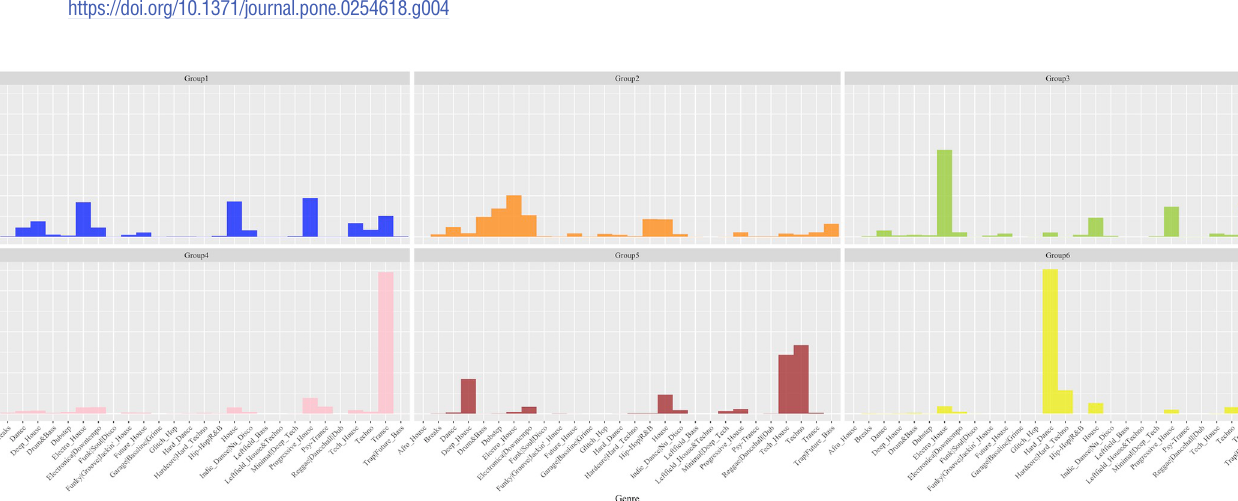
Fig 5. Genre distribution of detected groups. A total of 6 groups are detected using the fast greedy optimization algorithm: Group 1 (blue/Progressive House), Group 2 (orange/Dubstep, Drum, & Bass), Group 3 (green/Electro House), Group 4 (pink/Trance), Group 5 (brown/Techno, Tech House) and Group 6 (yellow/Hardcore, Hard